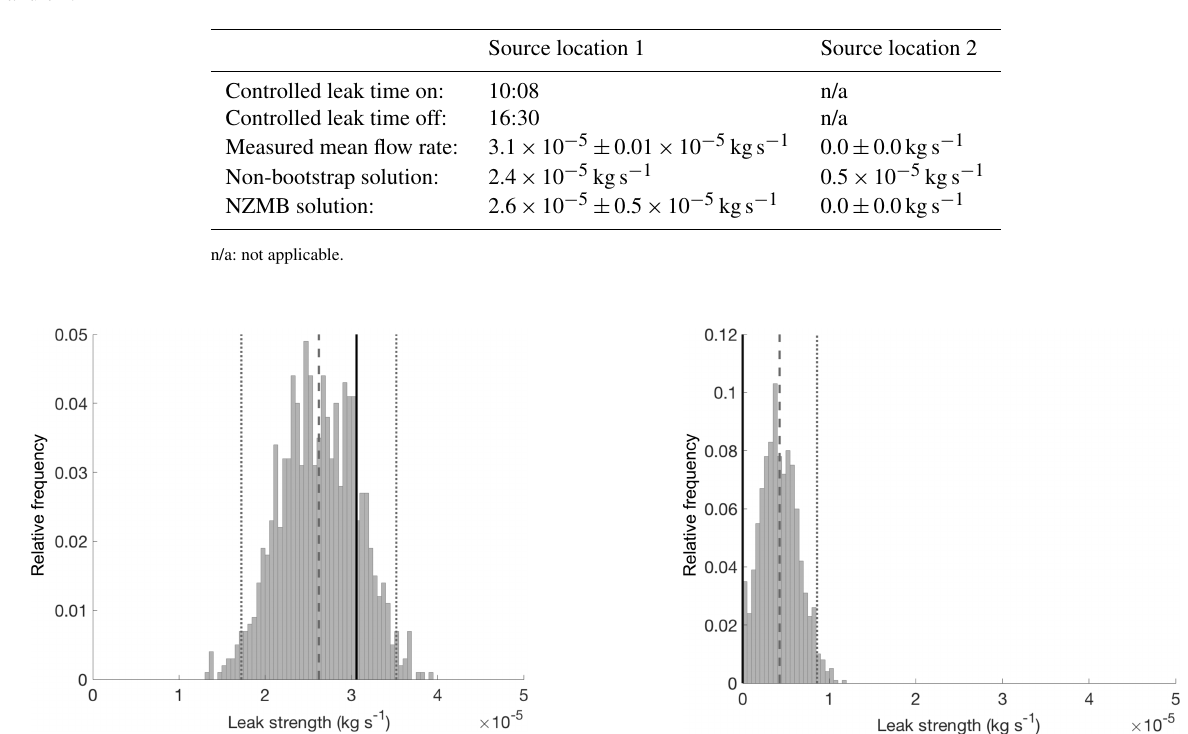
Figure 12. Histogram of NZMB estimated source strength at source location 2, with dashed line showing the bootstrap mean and thin dotted lines showing ± 2 standard deviation. The thick black line shows the true leak strength at source location 2 (0kgs − 1 ) . The presence of 0kgs − 1 in the histogram triggers acceptance of the null hypothesis (that the emissions rate at this site is